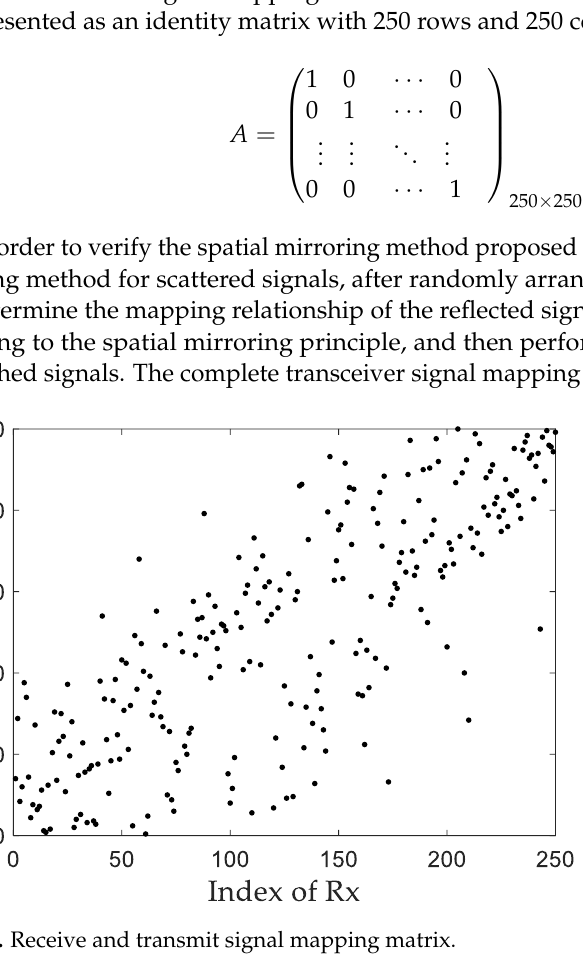
Figure 8. Receive and transmit signal mapping matrix.